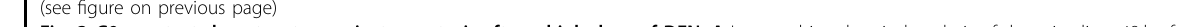
Fig. 3 G9a protects hepatocytes against apoptosis after a high dose of DEN. A Immunohistochemical analysis of the mice liver 48 h after administering a high dose of diethylnitrosamine (DEN) (100 mg/kg i.p.). G9a is upregulated after DEN administration, and cleaved-Caspase 3 induction occurs only in the G9a Δ Hep liver, whereas γ H2AX and p53 levels are comparable between wild-type (WT) and G9a Δ Hep livers. Bcl-G expression is elevated in the pericentral hepatocytes of G9a Δ Hep mice. Scale bars, 50 µm. The number of positive hepatocytes is shown in the graph below (** p < 0.01, NS not signi fi cant, Student ’ s t test). B Serum ALT levels are signi fi cantly elevated in G9a Δ Hep mice 48 h after administering a high dose of DEN. Data are represented as mean ± SEM (WT/DEN0h, n = 4; G9a Δ Hep /DEN0h, n = 3; WT/DEN48h, n = 5; G9a Δ Hep /DEN48h, n = 3). C Cyp2e1 expression, as assessed by qRT-PCR, is comparable between WT and G9a Δ Hep livers (each, n = 3; NS not signi fi cant, Student ’ s t test). D Top 10 upregulated genes in the non-tumorous area of G9a Δ Hep liver are listed. E qRT-PCR analysis validates Bcl-G upregulation in the G9a Δ Hep liver (* p < 0.05, Student ’ s t test). F Immunoblots reveal increased Bcl-G, cleaved-PARP, and cleaved-Caspase3 protein levels in the G9a Δ Hep liver 48 h after high-dose DEN administration. Right graph shows relative protein level of Bcl-G (each, n = 3; ** p < 0.01, NS not signi fi cant, Student ’ s t test). G Relative expression levels of G9a and BCL-G in human non-tumorous (NT) liver obtained in our institution. BCL-G expression is negatively correlated with G9a expression. (rho = − 0.37, p = 0.02, Spearman ’ s rank correlation coef fi